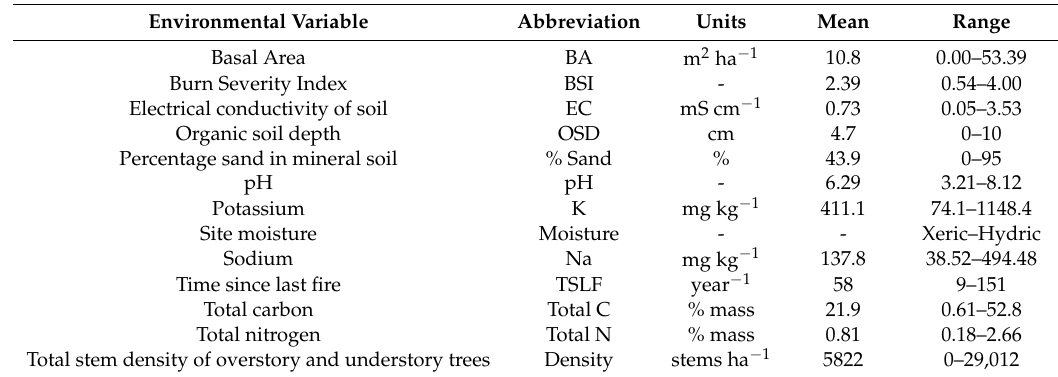
Table 1. Significant (* p ≤ 0.05) explanatory environmental variables fitted to nonmetric multidimensional scaling (NMDS) of the understory vegetation community data (Figure 2). Unitless variables are identified with a hyphen in the Units